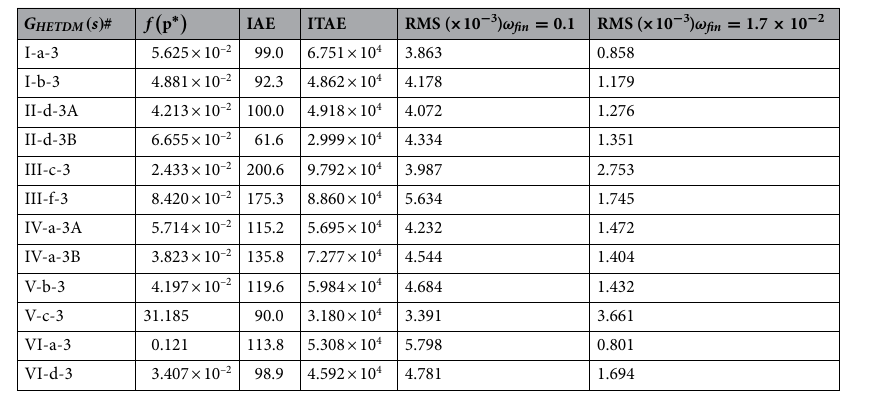
Table 12. HETDM time-domain and frequency-domain model errors (ad Table